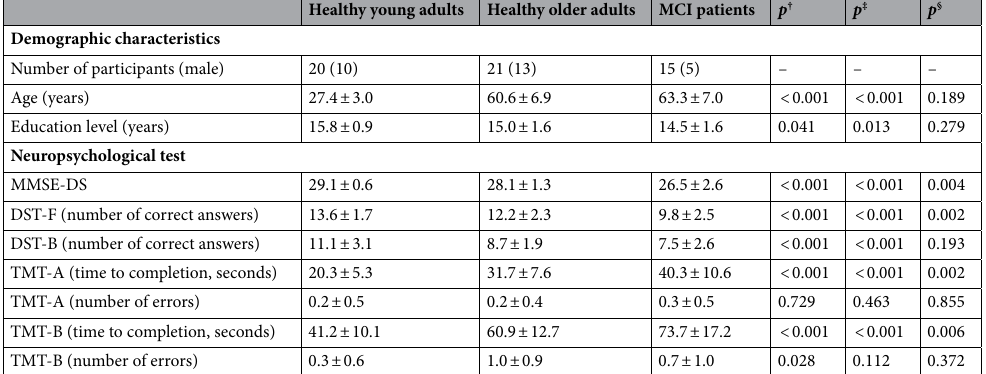
Table 1. Basic demographic characteristics and neuropsychological test results by group. Values are expressed as means ± SDs. MMSE-DS mini mental state examination-dementia screening, DST-F digit span test-forward,